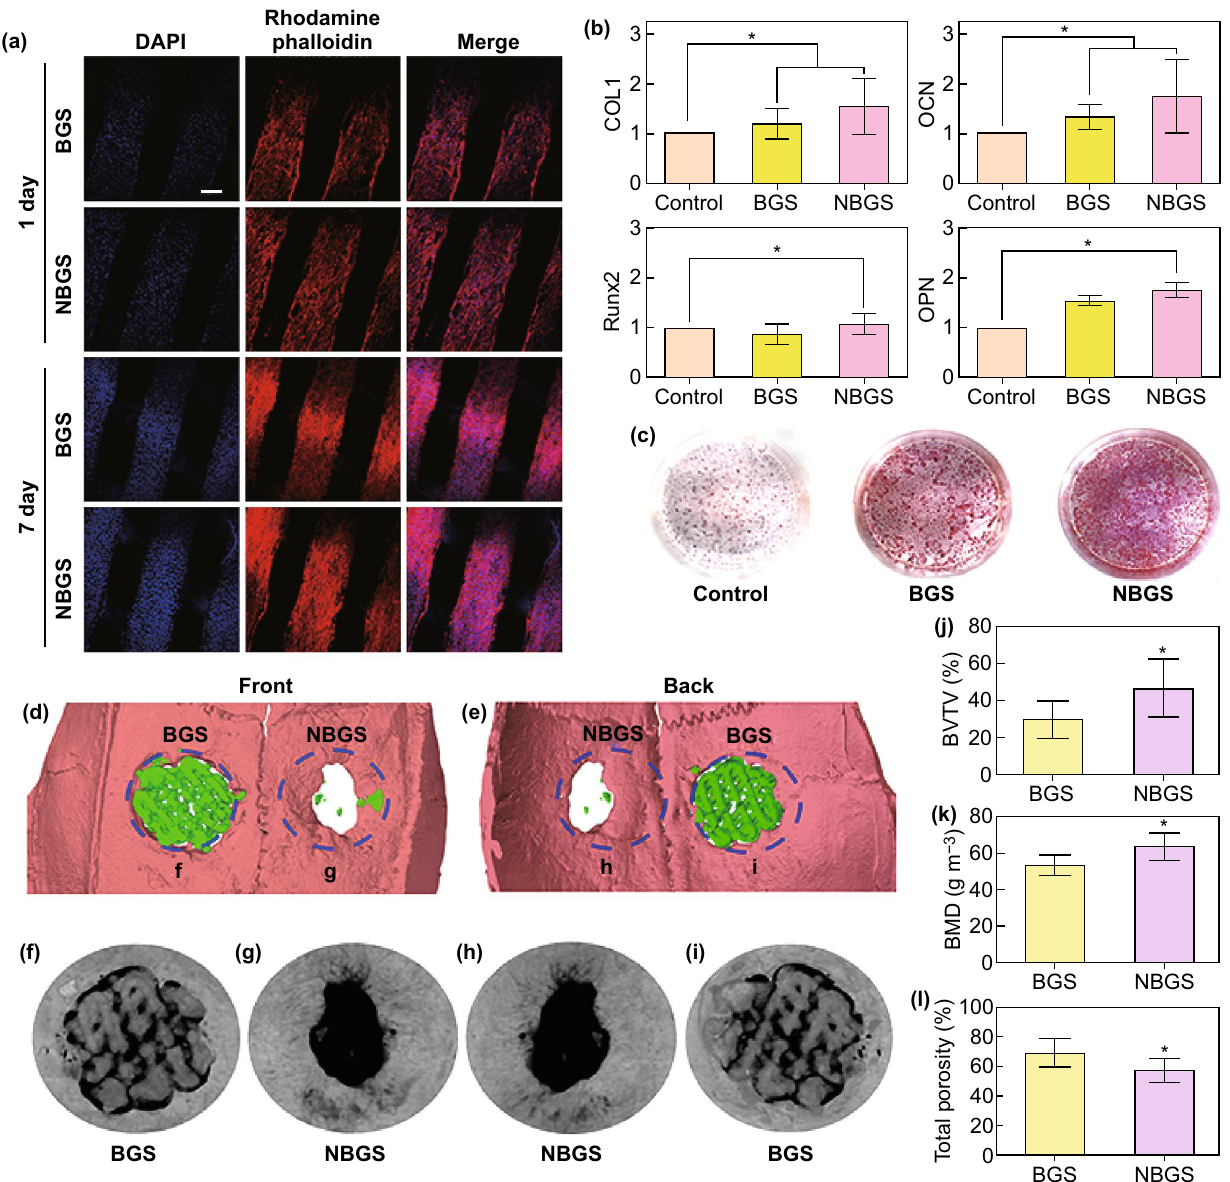
Fig. 5 In vitro proliferation and osteogenic differentiation of hBMSCs and in vivo material-guided bone regeneration of BGS/NBGS. a Confo- cal fluorescence images of hBMSCs co-cultured with BGS/NBGS stained with DAPI (cell nuclei, blue fluorescence) and rhodamine phalloidin (cytoskeleton, red fluorescence) at day 1 and 7. The representative images show cellular proliferation and adherence on BGS/NBGS (scale bar, 200 μm). b Osteogenic genes expression ( COL1 , RUNX2 , OCN and OPN ) of hBMSCs in control, BGS and NBGS group at day 3. c Alizarin red staining of control, BGS and NBGS at the 21th day, showing mineralized extracellular matrix. d, e 3D reconstruction of micro-CT scanning was obtained to assess the defect and bone regeneration with different scaffolds. f – i Micro-CT analysis of harvested skulls collected from the experimental rats after 24 weeks. The morphology of undegraded BGS is distinct. j – l Bone regeneration capability as evaluated by quantitative analysis of fundamental parameters of two different scaffolds. (Color figure